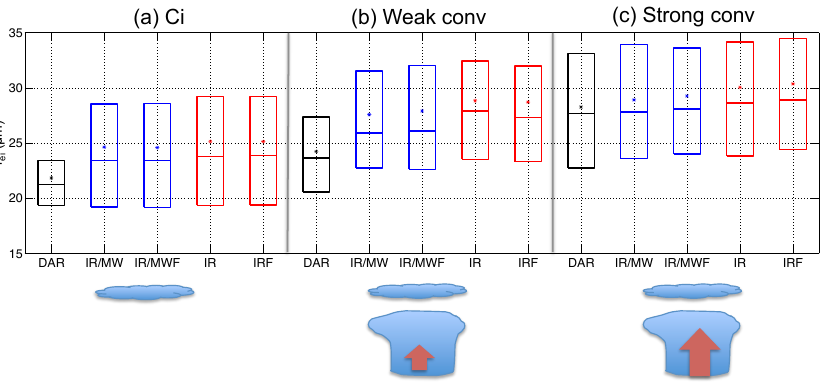
Figure 12. DARDAR (black), IR/MW (blue), and IR only (red) retrievals of r ei in single-layered cirrus (a) , cirrus on top of weak convection (b) , and cirrus on top of strong convection (c) ; see Sect. 3.4 for a description of the definition of convective intensity. The AIRS retrievals are also shown for a filtered version that removes retrievals within 6K of the tropopause. The central line is the median, the asterisk is the mean, and the bottom and top edges of the boxes are the 25th and 75th